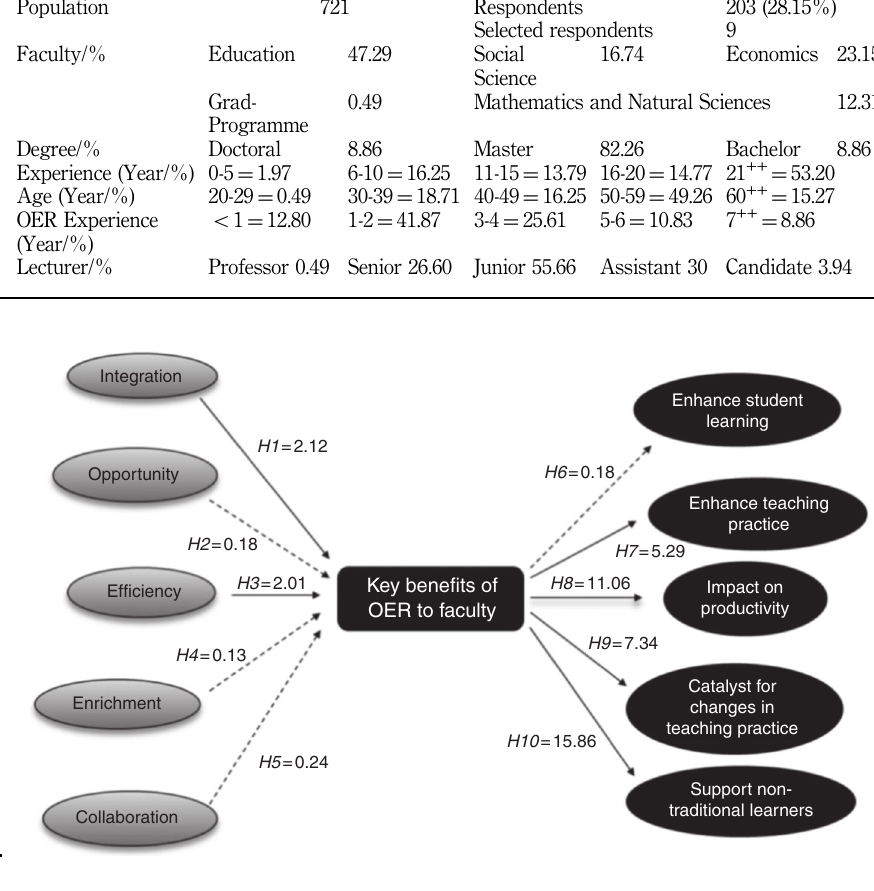
Figure 3. The t value of